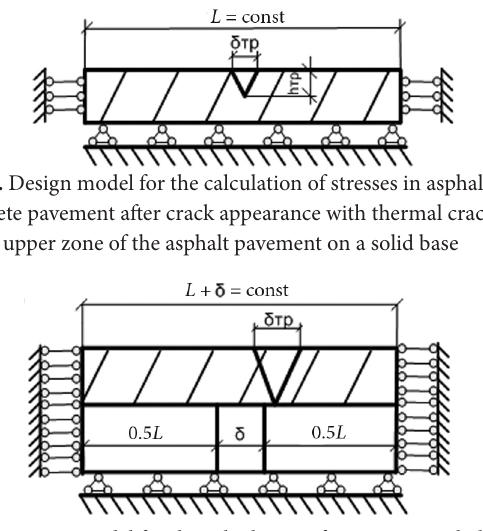
Fig. 5. Design model for the calculation of stresses in asphalt concrete pavement after crack appearance with reflected cracks in asphalt layer on a cracked